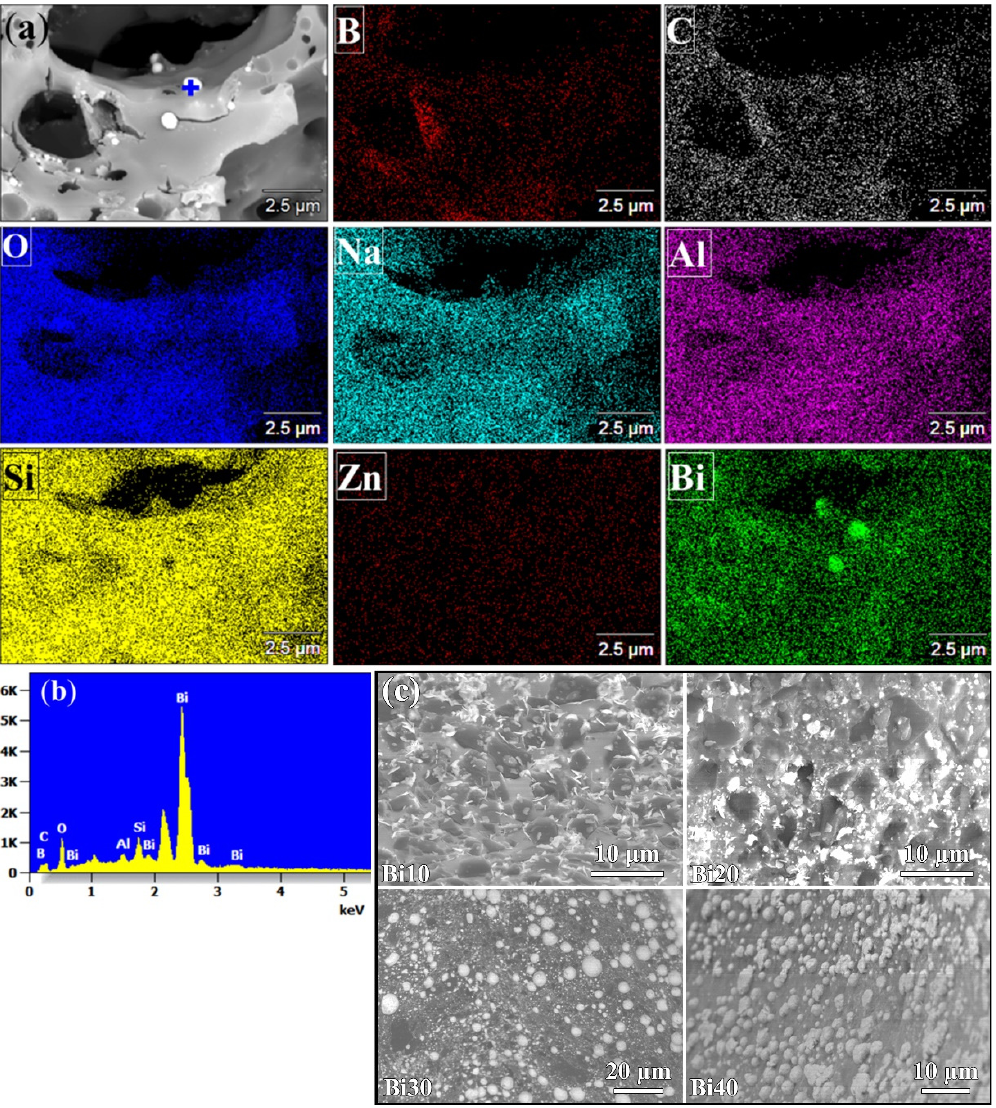
Figure 9. SEM morphologies of phase separation of the PSN/bismuth–borosilicate glass–B 4 C repair coatings: ( a ) elemental maps; ( b ) EDS analysis of ( a ); and ( c ) surface.